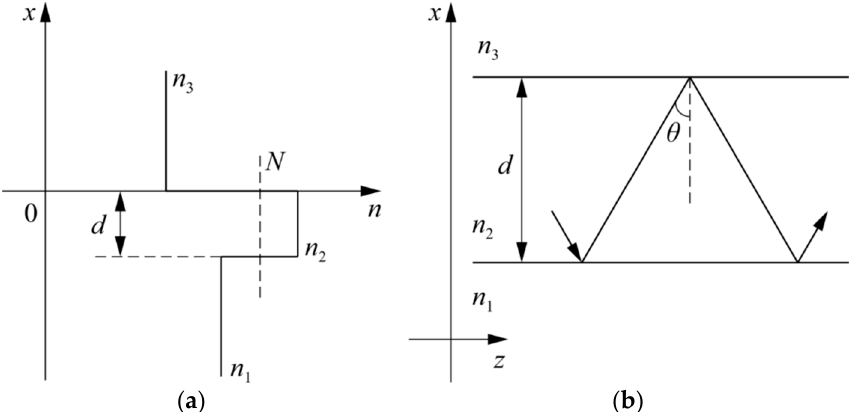
Figure 7. A waveguide model with a step-graded index: ( a ) a refractive index profile in a planar waveguide; ( b ) the scheme of light propagation within a waveguide in the ray approximation. n 1 = 2.20, n 2 = 2.21, n 3 = 1 are the refractive indices of the substrate, waveguide and coating (respectively), N is the effective refractive index, d is the thickness of the waveguide and θ is the angle of incidence of the beam on the interface.